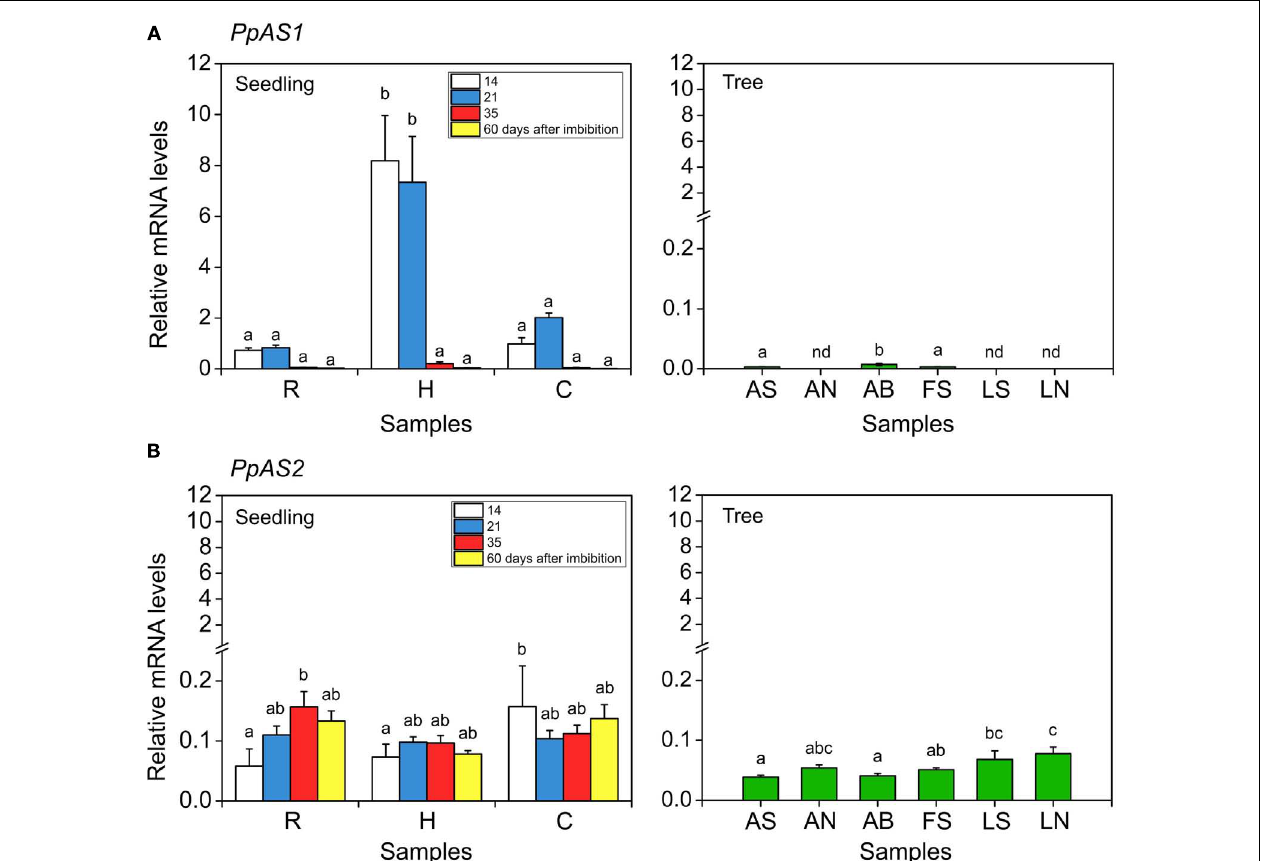
cDNA was amplified using specific primers for PpAS1 and PpAS2 genes. The levels of PpAS1 (A) and PpAS2 (B) transcripts were determined by real-time qPCR. Expression data were normalized using a geometric mean of three reference genes ( ACT , 40S , and EF1 α ). Means with different lowercase letters are significantly different, P ≤ 0.01 (one-way ANOVA and Tukey’s